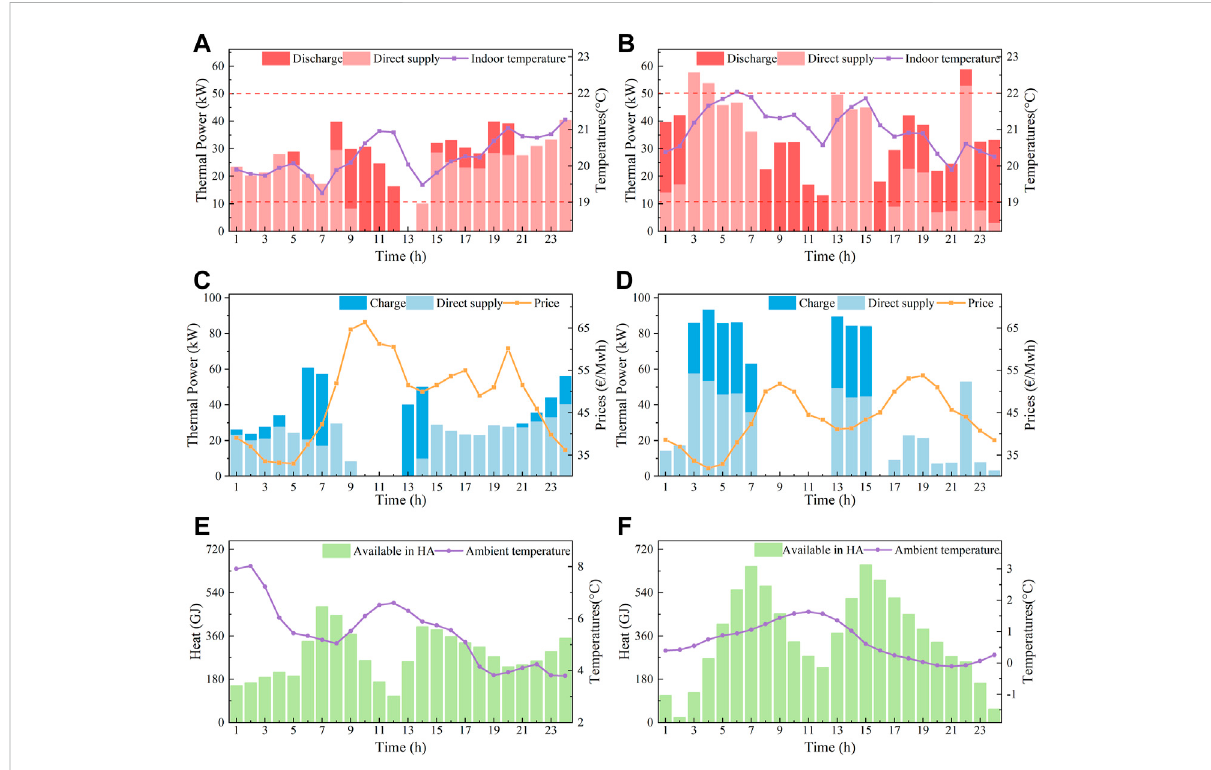
FIGURE 9 Scheduling results of 1 day in Scenarios 1 (left column) and 2 (right column) heating period: (A/B) output power of REB and average indoor temperatures, (C/D) input power of REB and electricity prices, and (E/F) available heat stored in heat accumulator and ambient